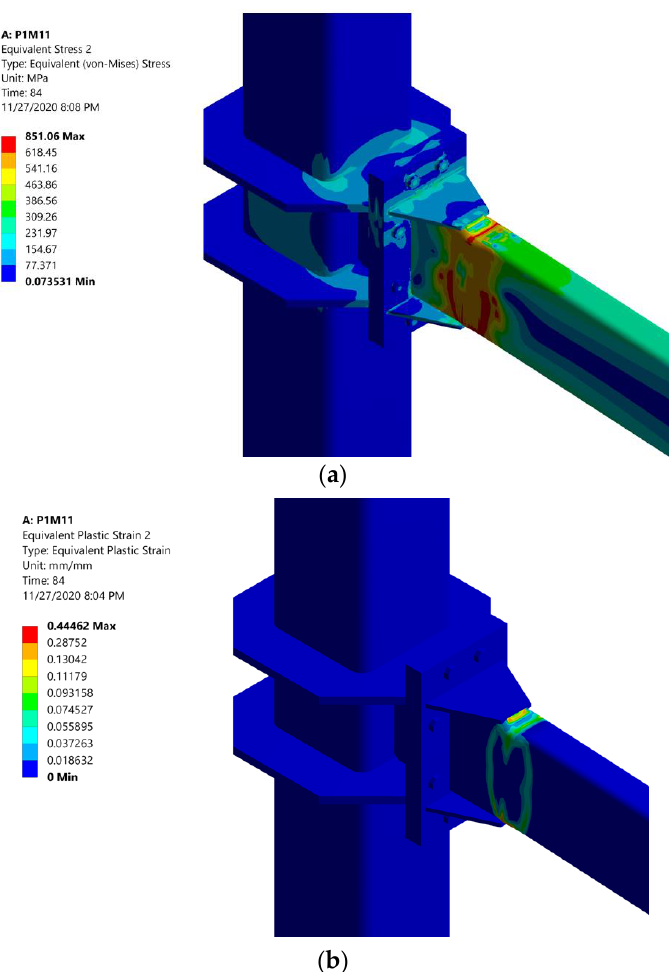
Figure 13. ( a ) Distribution of von Mises stress and ( b ) plastic strain, at maximum displacement of numerical model.